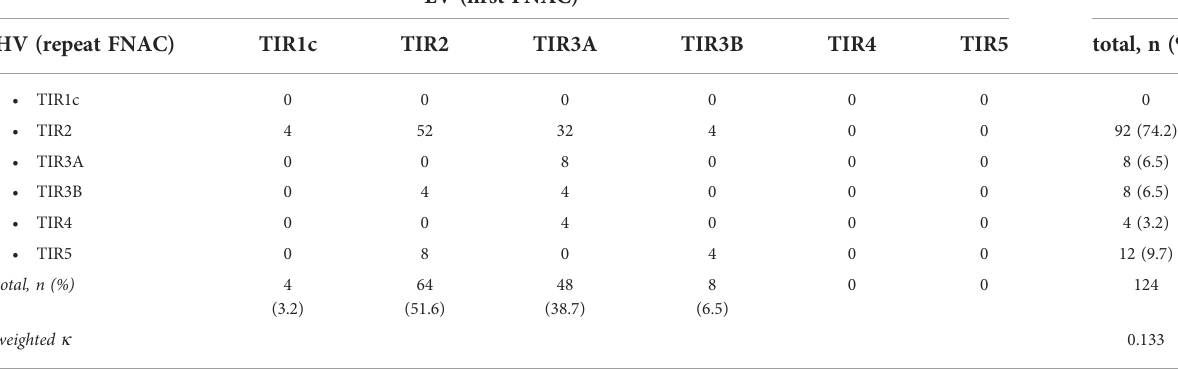
TABLE 3 Inter-observer agreement of thyroid FNAC results of the 124 included nodules between the two centers (i.e. LV center vs HV center) according to the